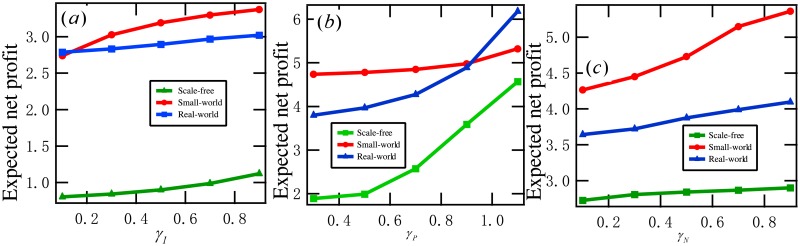
Experimental results in Example 6: (a) the optimal expected net profits for γP = 0.9, γN = 0.1, and γI ∈ {0.1, 0.3, ⋯, 0.9}, (b) the optimal expected net profits for γI = 0.3, γN = 0.1, and γP ∈ {0.3, 0.5, ⋯, 1.1}, (b) the optimal expected net profits for γI = 0.3, γP = 1.2, and γN ∈ {0.1, 0.3, ⋯, 0.9}.